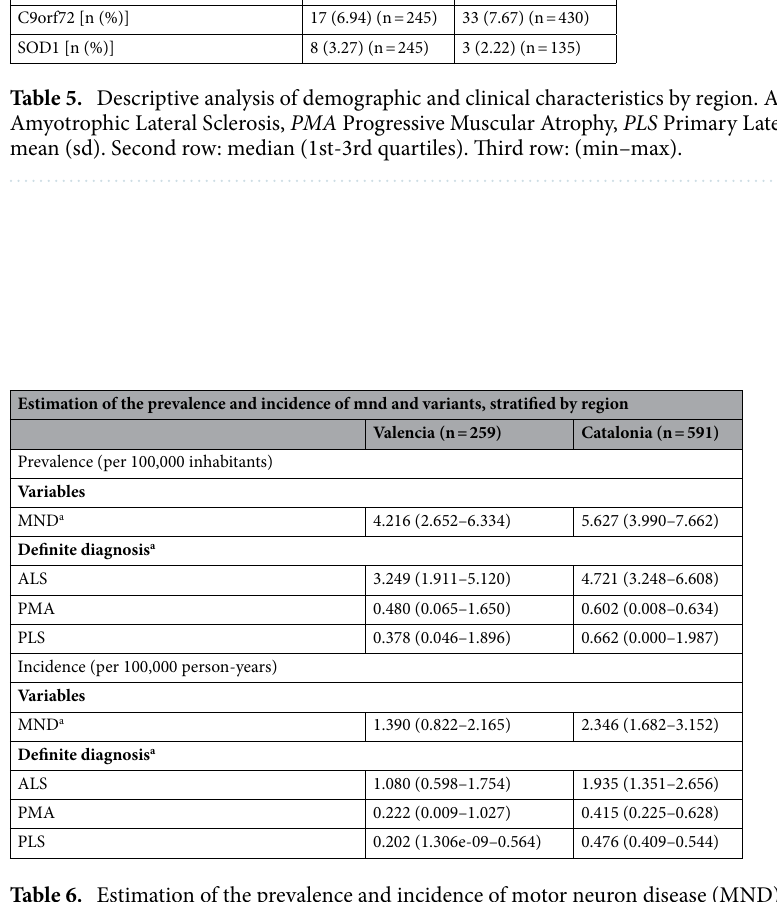
Table 6. Estimation of the prevalence and incidence of motor neuron disease (MND) and its variants in the regions of Valencia and Catalonia (2013–2018 and 2011–2019). MND Moto Neuron Disease, ALS Amyotrophic Lateral Sclerosis, PMA Progressive Muscular Atrophy, PLS Primary Lateral Sclerosis. a Point estimate (credibility interval at